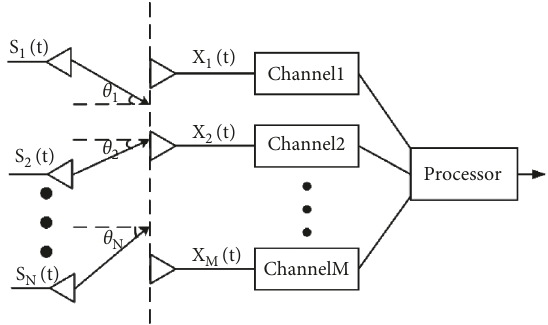
Figure 1: Diagram of the DOA estimation